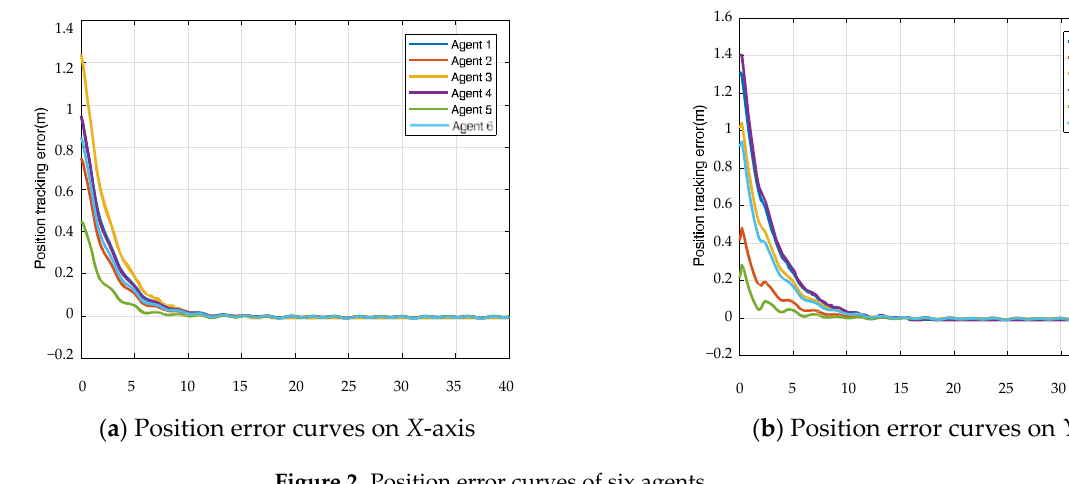
( b ) Velocity error curves on Y -axis Figure 3. Velocity error curves of six agents. ( a ) Actual position on X -axis ( b ) Actual position on Y -axis Figure 4. The actual positions of six agents.